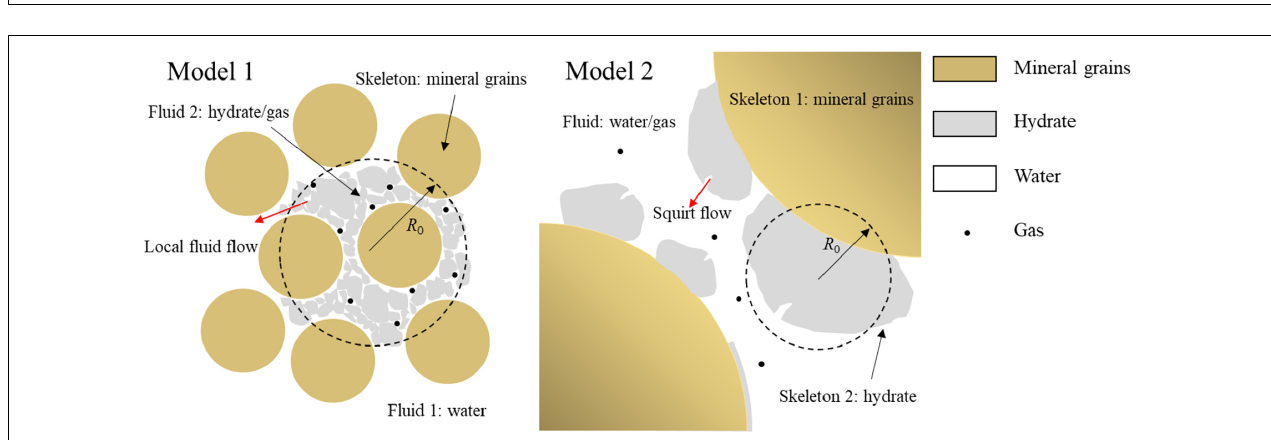
FIGURE 3 | Modeling workflow methods for the two models.